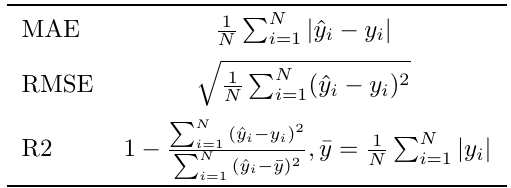
Table 5. Regression performance evaluation